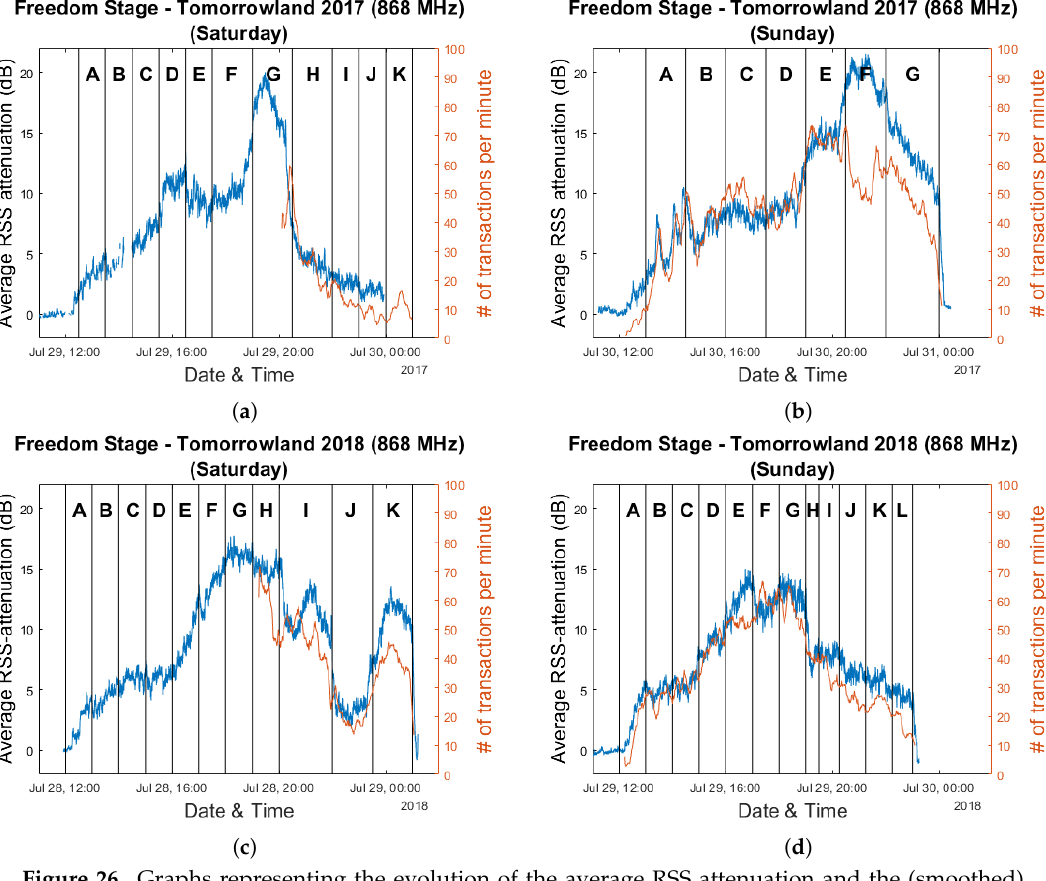
Figure 26. Graphs representing the evolution of the average RSS attenuation and the (smoothed) number of cashless transactions per minute for the 2017 and 2018 editions of the Tomorrowland festival within the Freedom Stage environment. Plots ( a , b ) are based on data collected on Saturday 29 July 2017 and Sunday 30 July 2017. Plots ( c , d ) are based on data collected on Saturday 28 July 2018 and Sunday 29 July